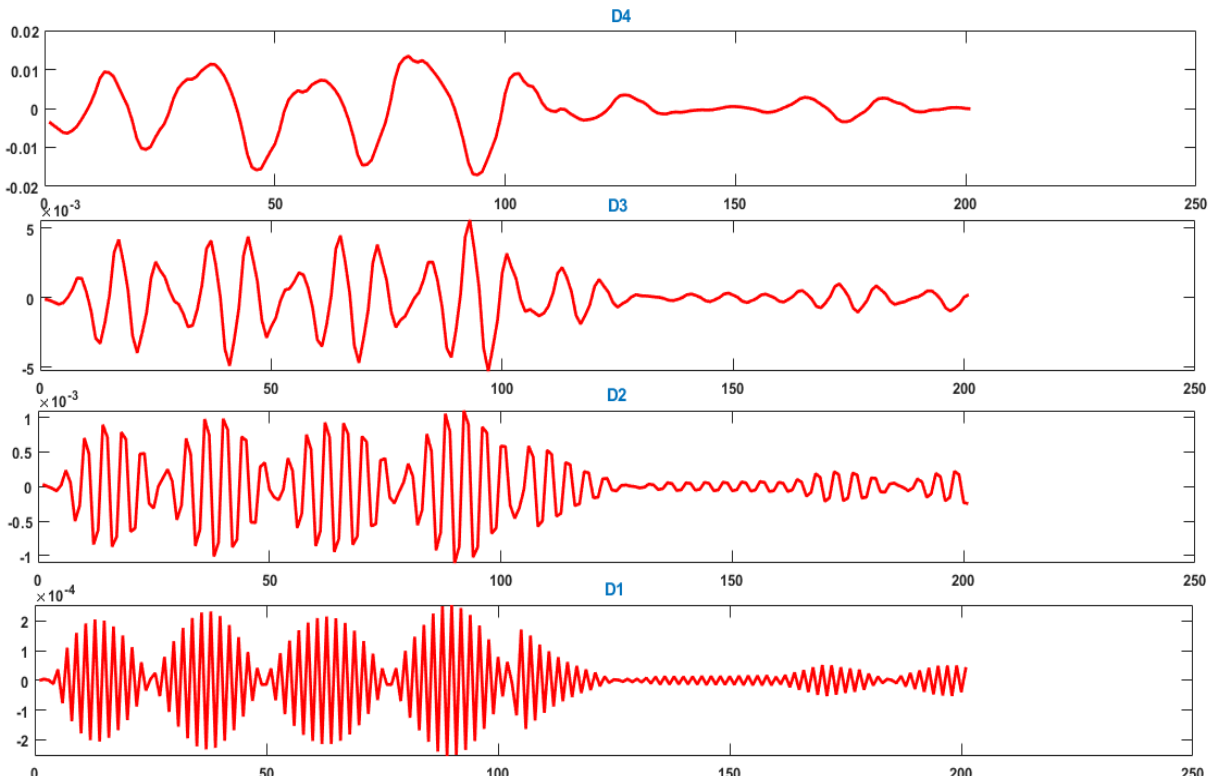
Figure 9. DWT process with four decomposition